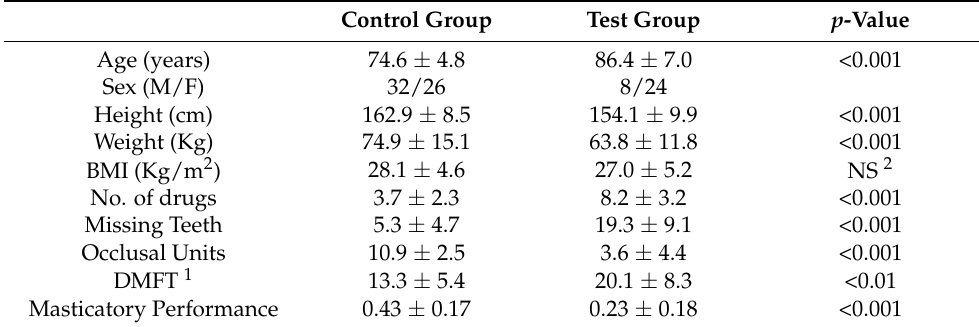
Table 2. Sociodemographic and Oral health related data of the studied groups. Data are expressed as Mean ± Standard Deviation. Control Group Test